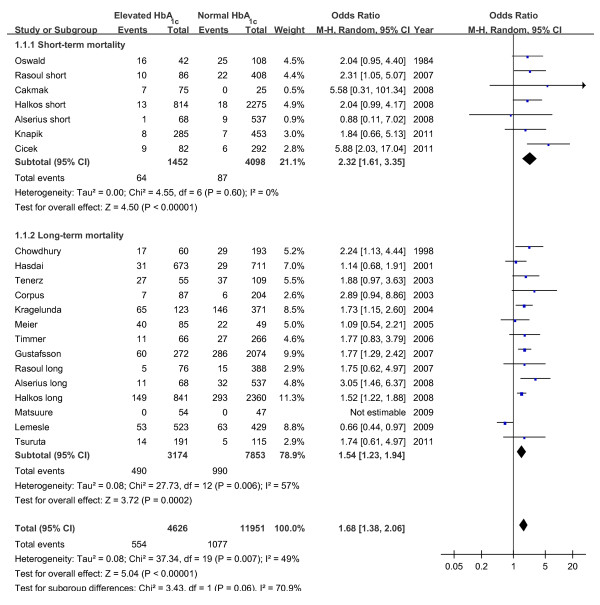
Unadjusted risk of short and long term mortality based on elevated or normal HbA1c level.